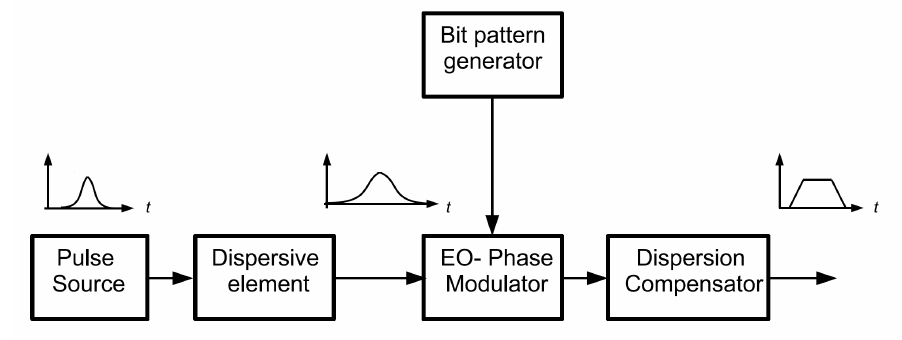
Figure 1. Time domain pulse shaping block diagram with binary phase modulation. EO: